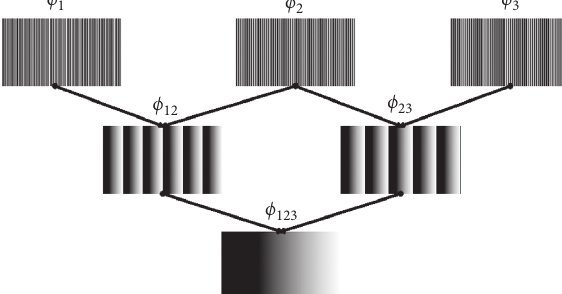
Figure 2: Schematic diagram of multifrequency